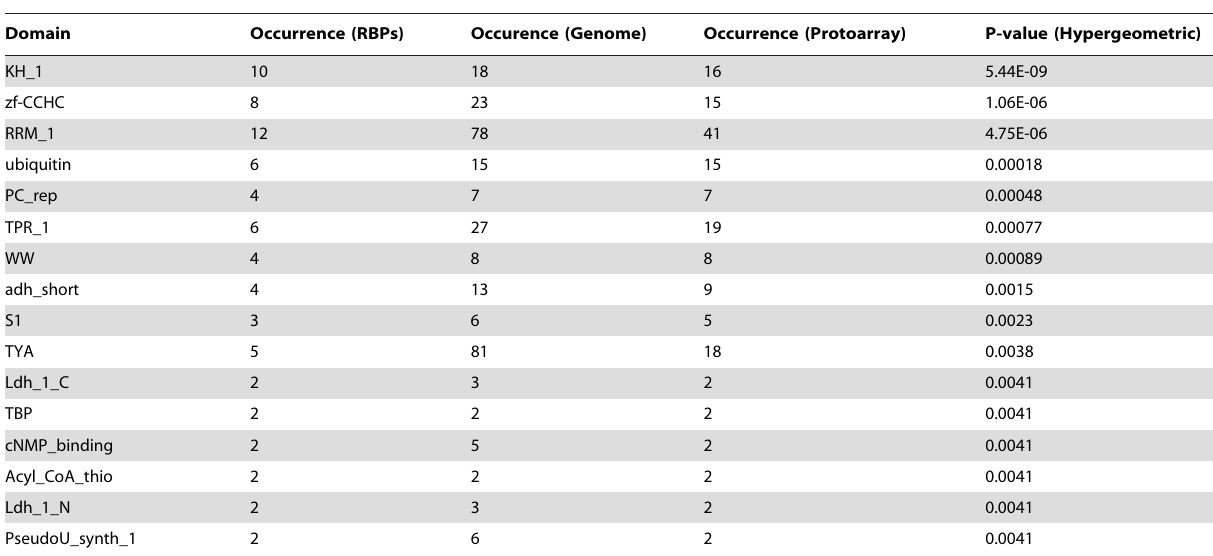
Table 1. Pfam domains enriched in the list of putative RBPs.